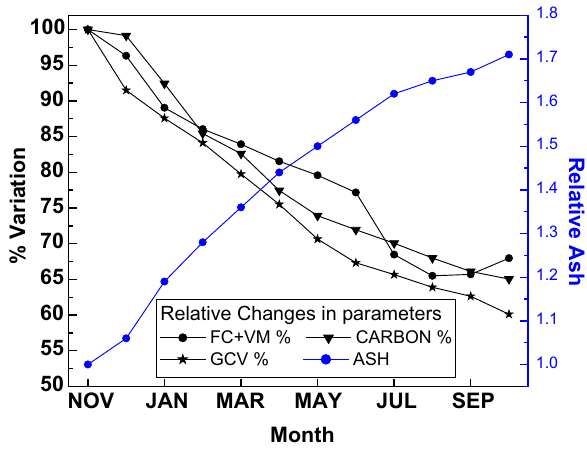
Fig. 5 Relative change in combustibles, carbon, gross calorific value and ash percentage during weathering